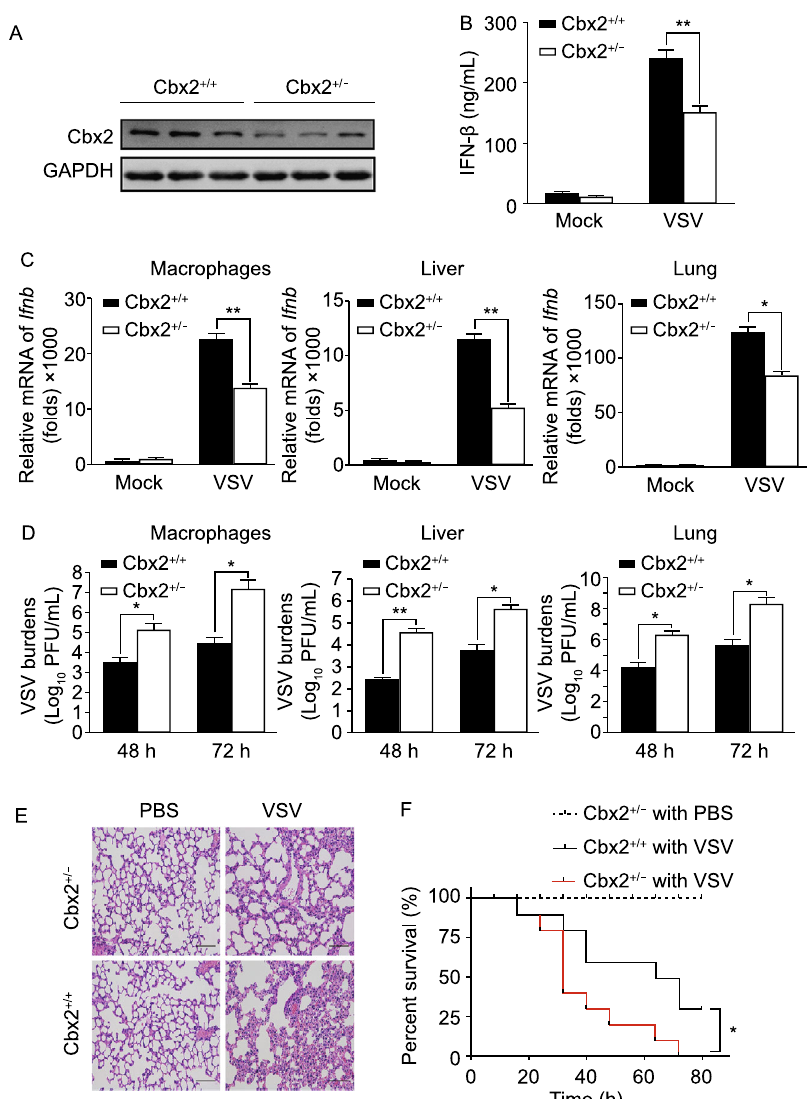
Figure 3. Knockdown of Cbx2 increases susceptibility to VSV challenge. (A) Western blot analysis of Cbx2 expression level in peritoneal macrophages derived from Cbx2 +/ − mice as compared to Cbx2 +/+ mice. (B) ELISA of IFN- β in serum of Cbx2 +/ − mice and Cbx2 +/+ mice ( n = 6 per group) after challenge by tail vein injection (IOCV) of VSV (2 × 10 6 PFU/g) for 18 h. (C) mRNA level of Ifnb in macrophages, livers and lungs derived from Cbx2 +/ − mice or Cbx2 +/+ mice after challenge with VSV (2 × 10 6 PFU/g) for 18 h. (D) Plaque assay of VSV burden. Vero cells were infected at a MOI of 0.001 PFU/cell. Viral burdens were quanti fi ed by plaque assay in Vero cells after 48 h and 72 h and reported as log 10 PFU/mL. (E) Hematoxylin and eosin staining of lung sections from Cbx2 +/ − and Cbx2 +/+ mice with or without challenge with VSV (2 × 10 6 PFU/g) for 18 h. Scale bar, 100 μ m. (F) Survival of Cbx2 +/ − and Cbx2 +/+ mice ( n = 10 per group) after challenge with VSV (1 × 10 7 PFU/g) for the indicated times. * P < 0.05 (Log rank test). The data in panels (B – D) is from three independent experiments (mean ± SEM of technical triplicates). All data are representative of three independent experiments with similar results. * P < 0.05; ** P <